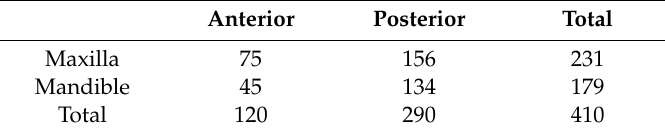
Table 2. Frequency of implant distribution by jaw and site of